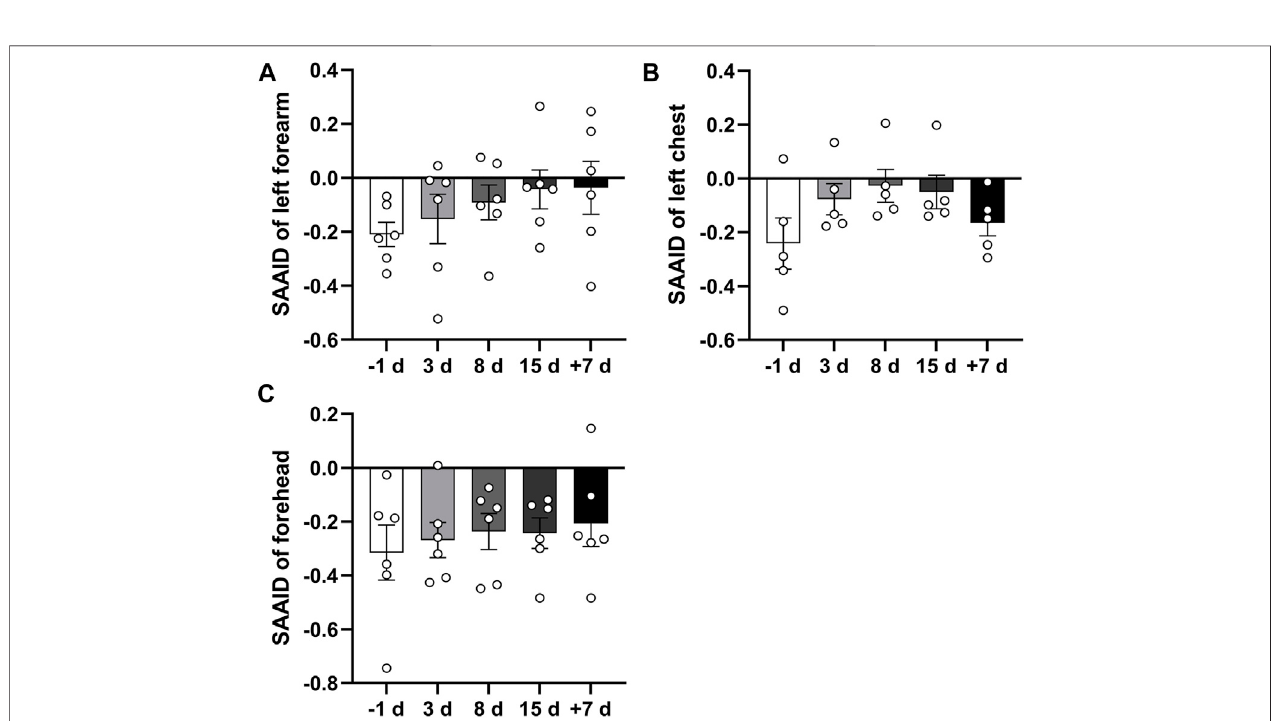
FIGURE5| Qualitativecomparison ofskinSAAIDduring15 days ofhead-downbedrest. (A – C) ChangesinSAAIDindexcalculated fromTPEFandSHG valuesof left forearm, left anterior chest, and forehead during 15-day bed rest with head down. Data represent mean ± SEM. Signi fi cant values are determined as * p < 0.05 (Tukey ’ s multiple comparisons paired